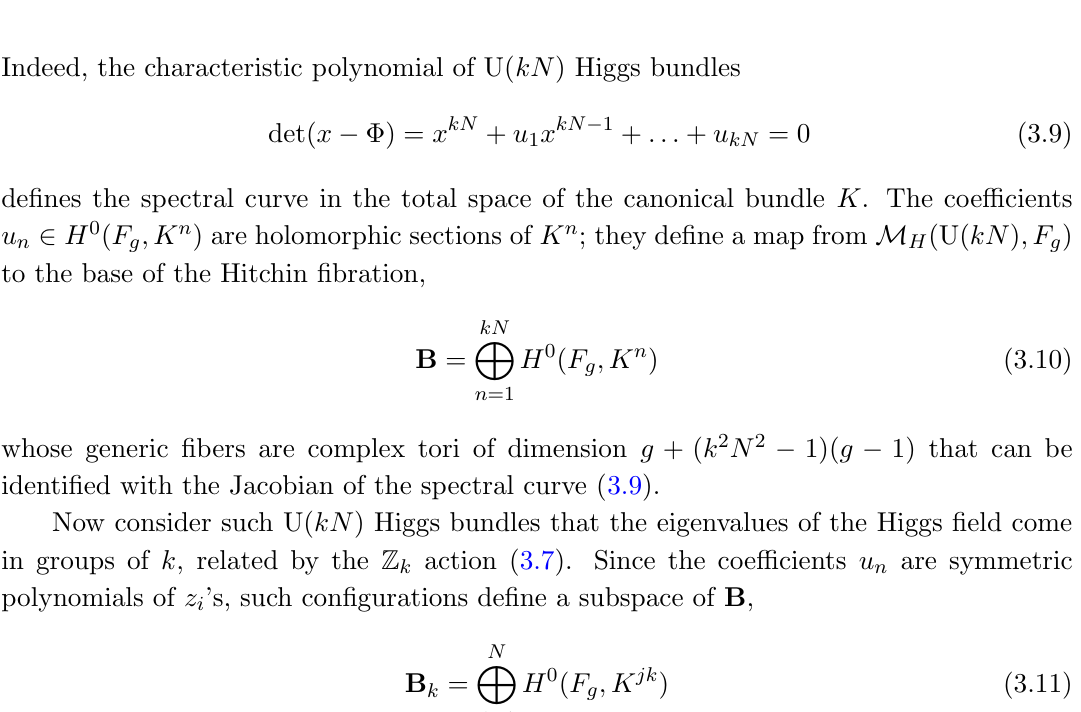
Table 6 . Order- k elements of the SL(2 ; Z ) duality group and the corresponding values of (cid:28) 4d (cid:12)xed by the Z k